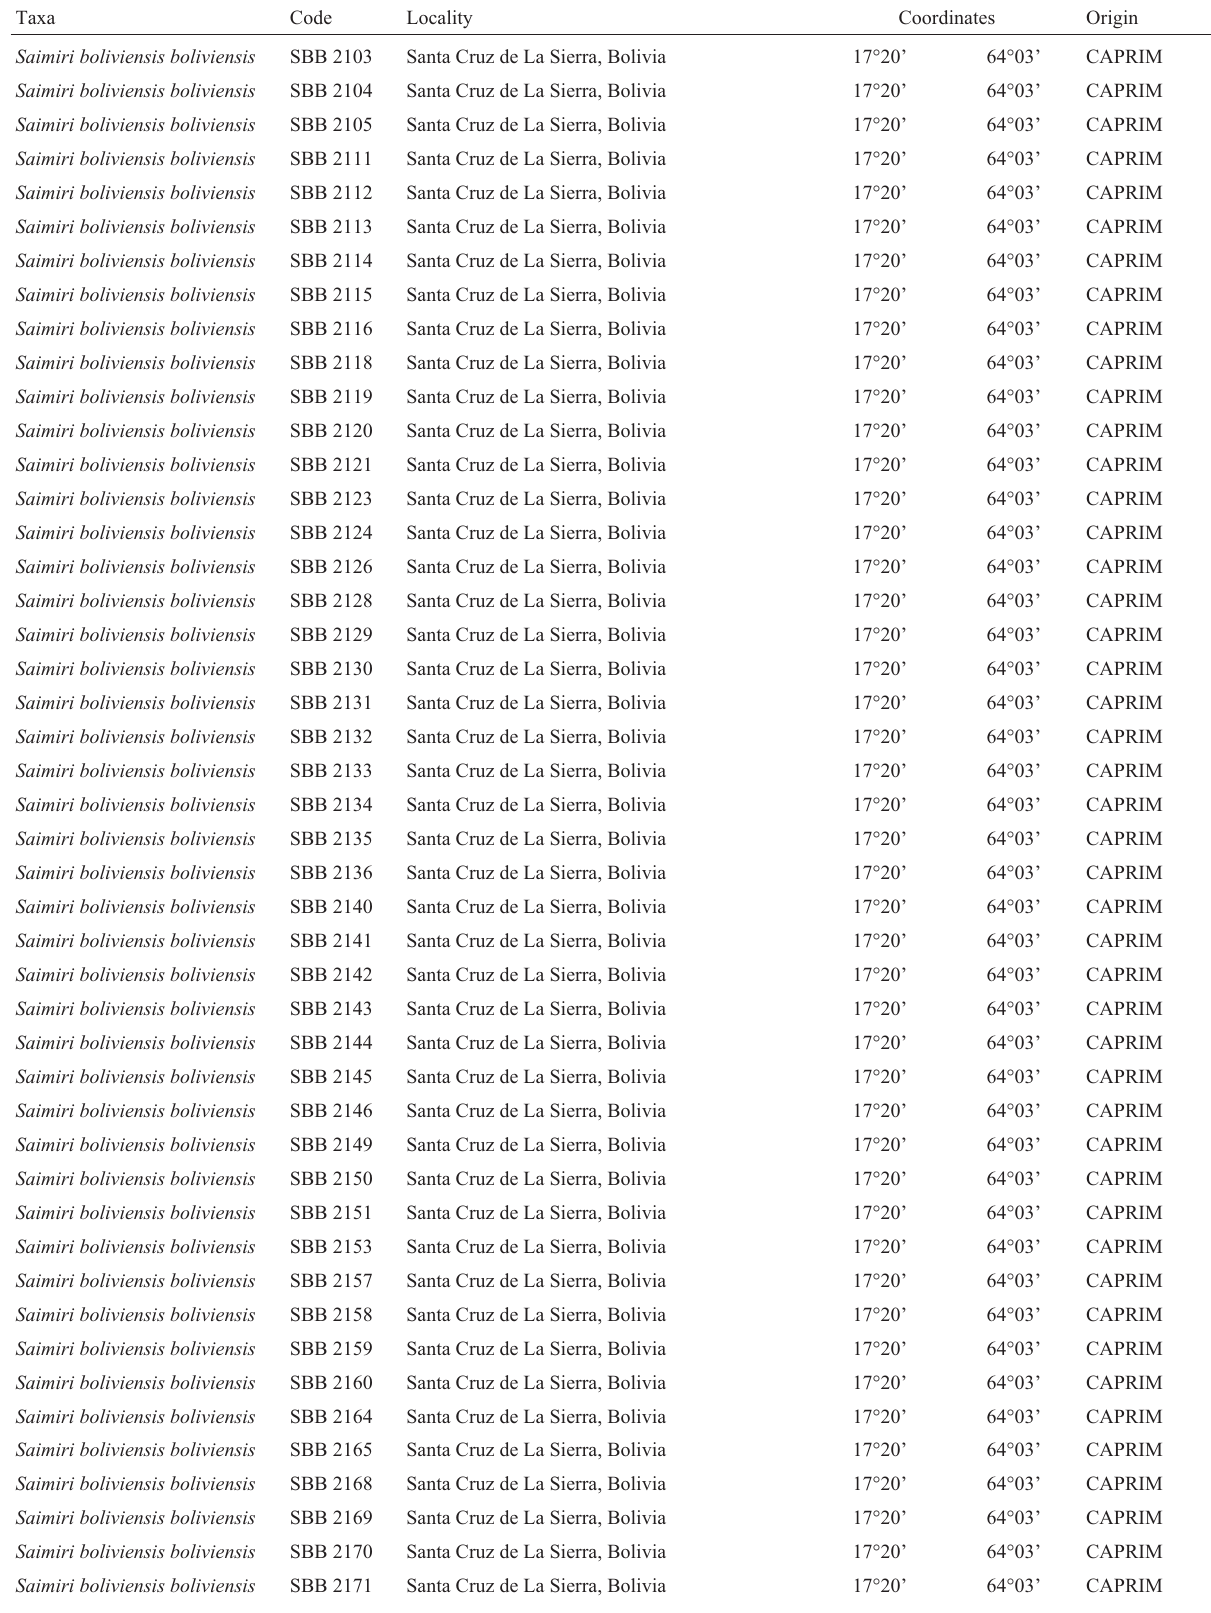
Table 1 - Species, specimen code, locality, geographical coordinates and origin of the specimens analyzed in the present